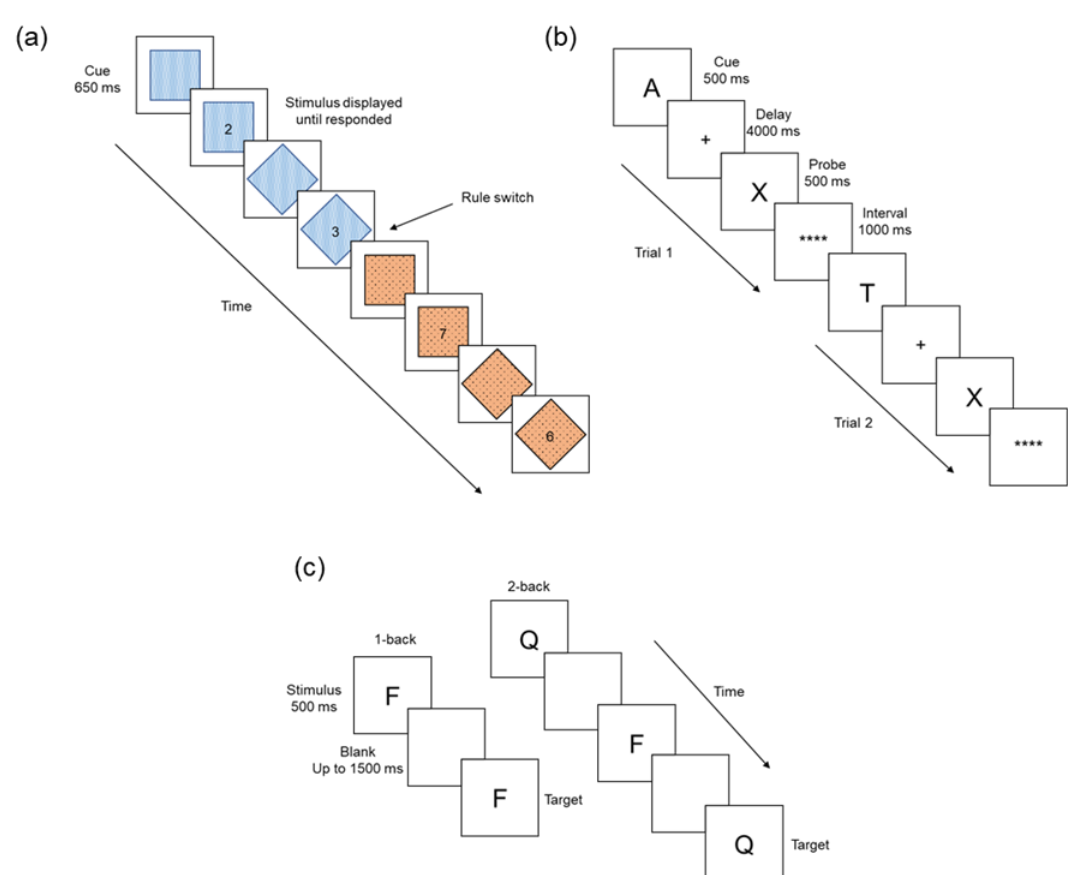
Figure 1. Schematic representations of each cognitive task. ( a ) In the switching task, participants are presented with a cue (empty blue/orange shape), followed by a number stimulus. Participants respond according to the rule (determine odd/even or higher/lower than 5), indicated by the colour of the shape (blue or orange). ( b ) In the AX Continuous Performance Task (AX-CPT) task, participants are presented with a cue-probe pair separated by a long delay (+). When **** appeared on the screen, participants respond by pressing the ‘m’ key when the cue is ‘A’ and probe is ‘X’; otherwise, participants respond with the ‘z’ key. The first trial is an example of a target trial (AX) and the second trial is an example of a BX non-target trial type (the cue “T” is incorrect in this case). ( c ) In the n-back task, participants respond with the ‘m’ key when the target is the same as the stimulus presented either 1 or 2 trials earlier (e.g., if the target is the same as the previous letter in the 1-back version); otherwise, participants respond with the ‘z’ key.